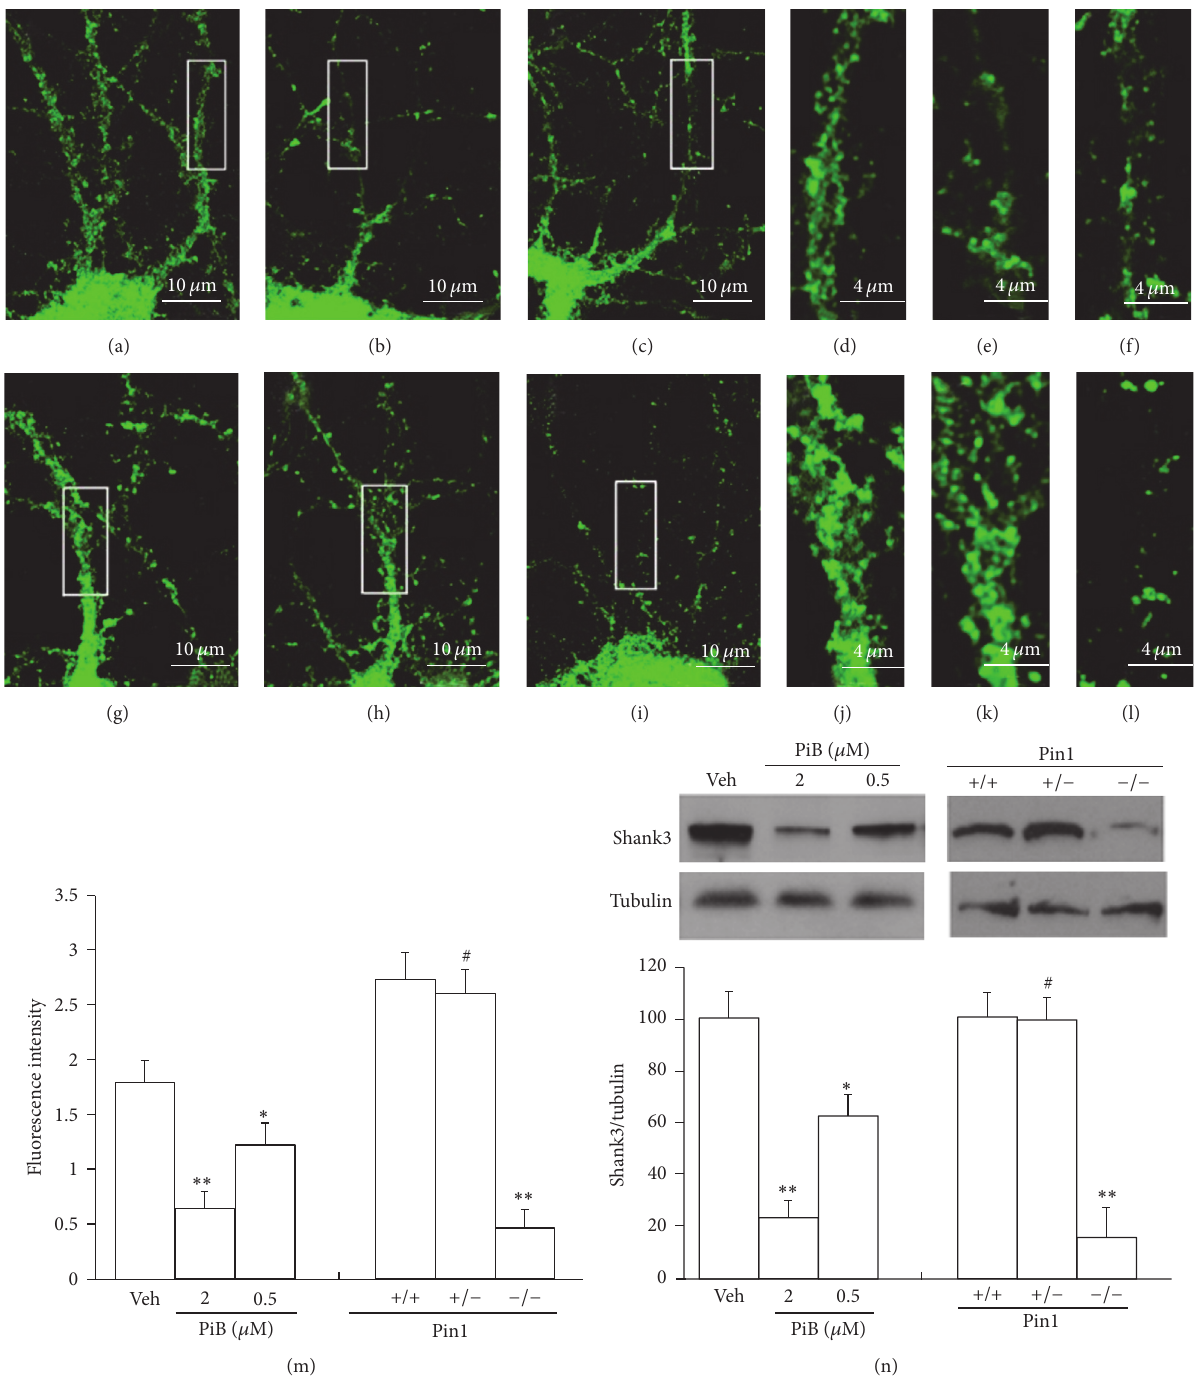
Figure 5: Blocking of Pin1 activity leads to degradation of Shank3 proteins in PSD. Cultured cortical neurons at 21 DIV were prepared on coverslips for immunofluorescence detection and in 10cm dishes for immunoblot assay. Panels (a)–(f) showed the cultured cortical neurons of C57/BL6 mice at 21 DIV treated with vehicle (a and d), 2 𝜇 M PiB (b and e), or 0.5 𝜇 M PiB (c and f) for 24 h; panels (d), (e), and (f) were the high-magnification images of selected fields. Panels (g)–(l) showed the cultured cortical neurons of Pin1 +/+ (g and j), Pin1 +/− (h and k), and Pin1 −/− (i and l) mice at 21 DIV; panels (j), (k), and (l) were the high-magnification images of selected fields. These neurons on coverslips were fixed, permeabilized, and labeled by Shank3 antibody for immunofluorescence detection by immunocytochemistry. (m) Immunofluorescence intensity demonstrated a large PiB-induced decrease in Shank3 proteins from seven independent experiments ( ∼ 90 neurons for each experimental condition, ∗∗ 𝑝 < 0.01 ; ∗ 𝑝 < 0.05 ). (n) Western blots showed significant decrease in the levels of Shank3 proteins in PiB-treated or in Pin1 −/− neurons compared with vehicle-treated or Pin1 +/+ neuron extracts, respectively ( 𝑛 = 7 dishes for each experimental condition, ∗∗ 𝑝 < 0.01 ; ∗ 𝑝 < 0.05 ; # 𝑝 > 0.05